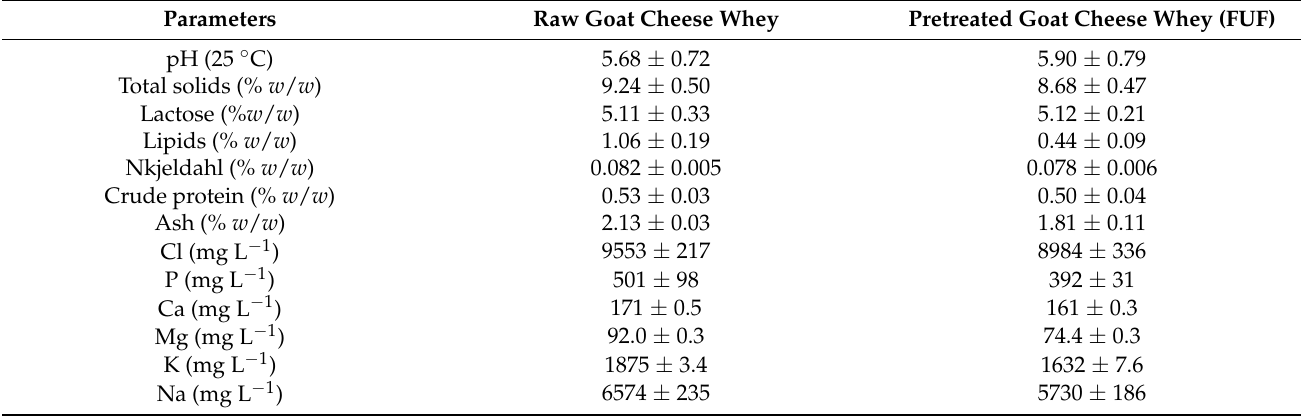
Table 2. Average composition (mean ± standard deviation) of raw goat cheese whey and pretreated goat cheese whey a . Parameters Raw Goat Cheese Whey Pretreated Goat Cheese Whey